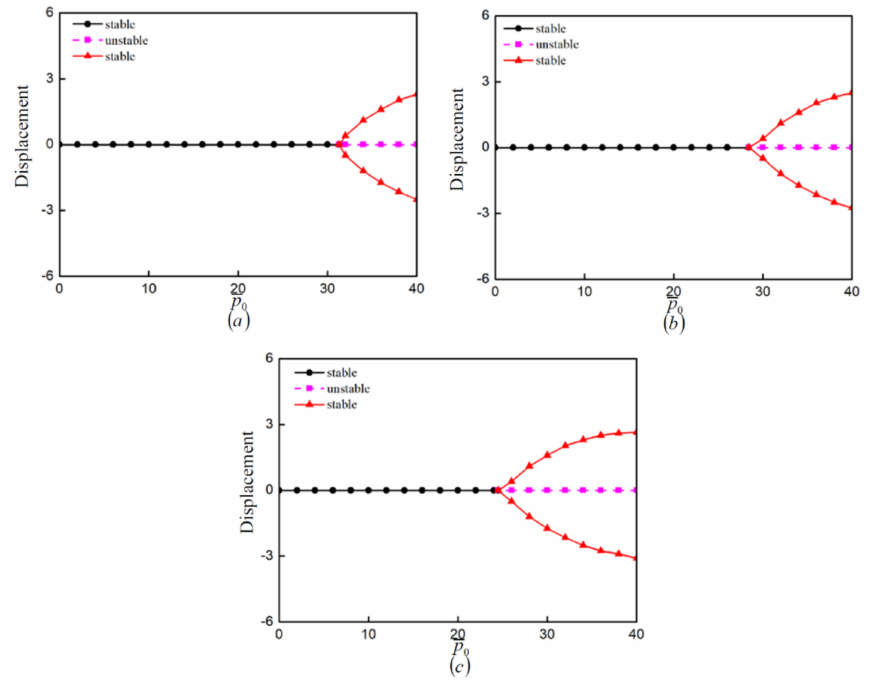
Figure 6. The transverse deflection of the CFRP laminated cylindrical shell versus the static in-plane load with different numbers of layers N s : ( a ) N s = 8, ( b ) N s = 6, ( c ) N s =